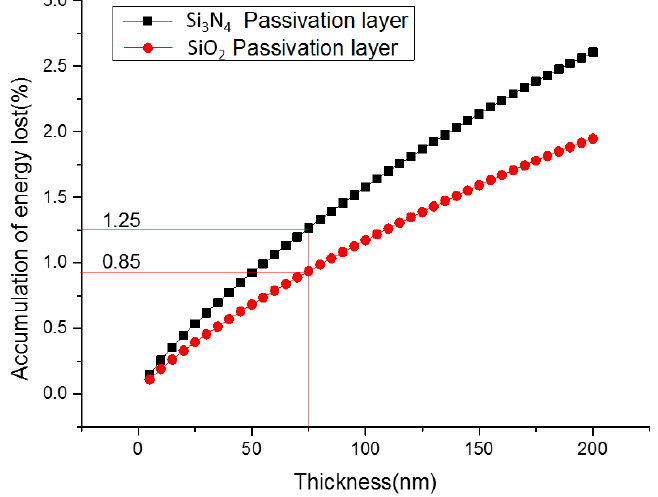
Figure 6. Radioisotope energy lost difference in the passivation layer with SiO 2 and Si 3 N 4 materials.